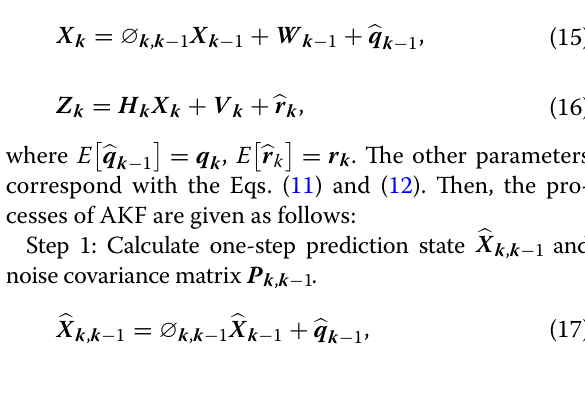
where x , y and θ are predicted states.